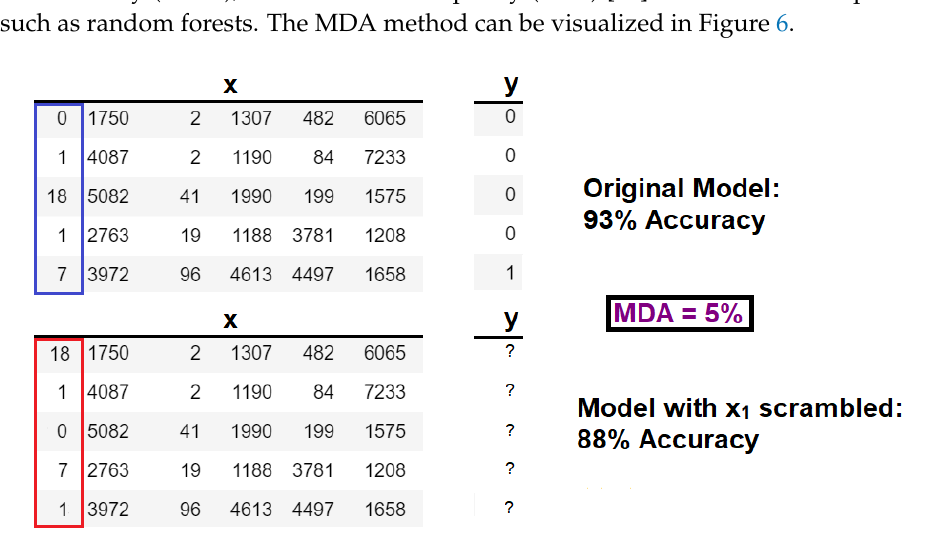
Figure 6. Mean decrease in accuracy (MDA) applied on a dataset with six features. During each outer iteration, the values of a single feature are scrambled or permutated sample-wise. The model accuracy with the scrambled feature is compared against the base-case model accuracy. If the accuracy decreases significantly, then the feature is considered “important.” On the other hand, if the accuracy decreases negligibly, then the feature is “irrelevant” to the